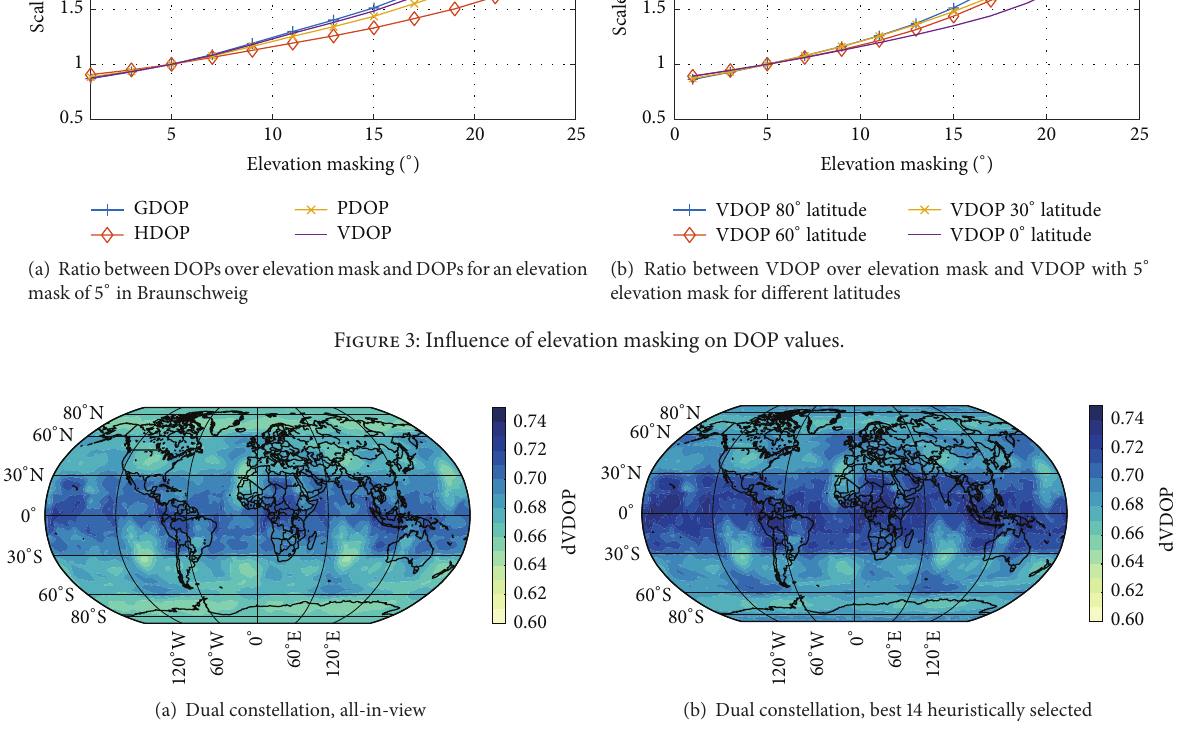
Figure 4: Decrease of VDOP in comparison to single constellation GPS ( 5 ∘ elevation